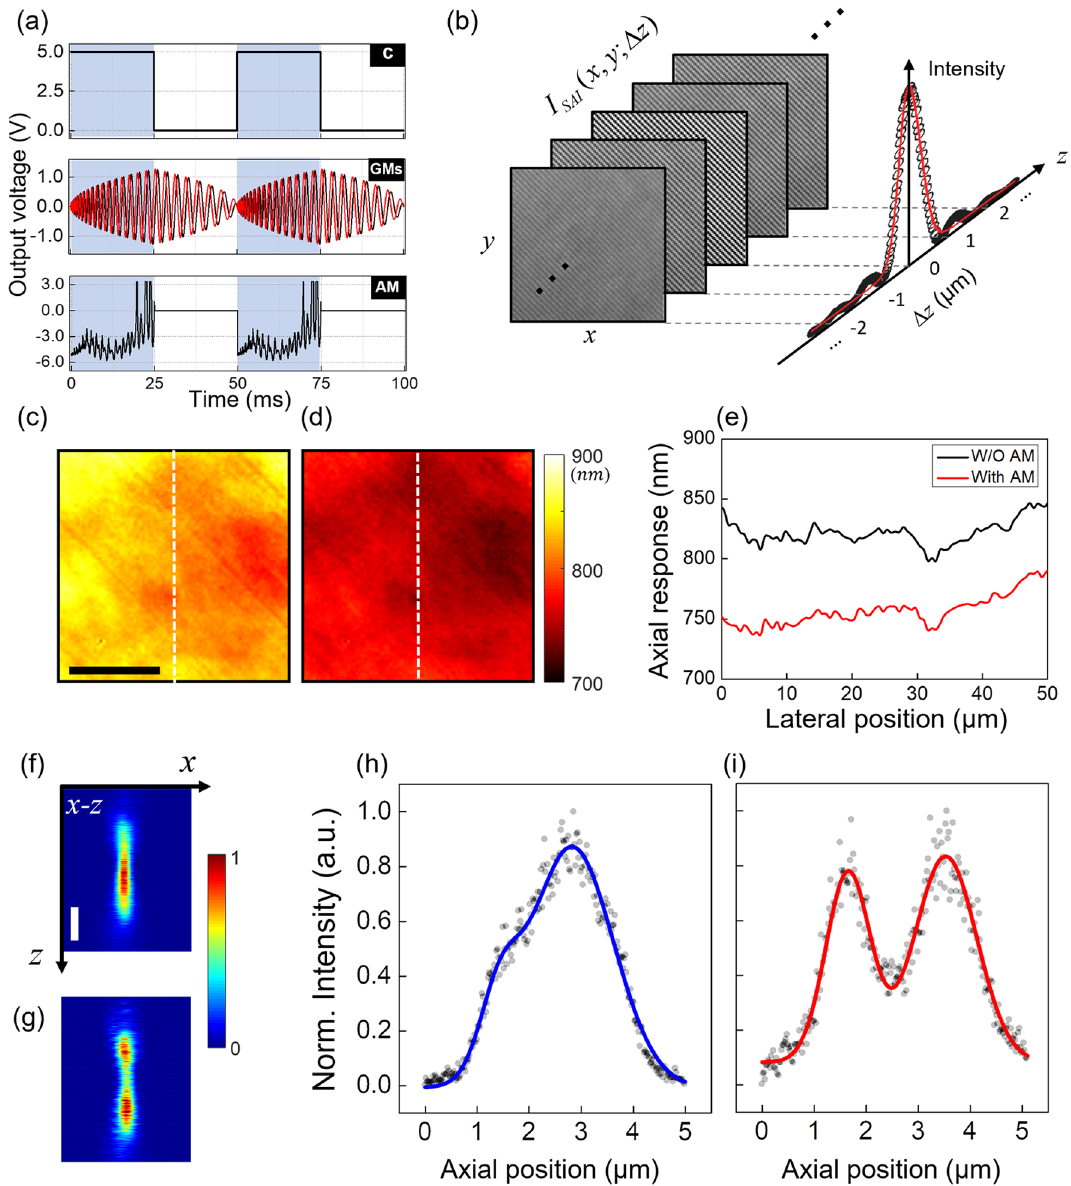
Figure 4. Enhancement of the axial resolution. ( a ) Time sequences of external triggers for the operation of devices in the setup. C: camera; GMs: Galvanometer mirrors; AM: amplitude modulator. ( b ) Measured interferograms (left) and intensity of the image (right) as a function of (cid:31) z . The red line is a Gaussian fit. ( c ) Map of the measured axial resolution over the FOV before the AM control. ( d ) The same as ( c ) after the AM control. Scale bar: 20 μm. ( e ) Section profiles along the dashed lines in ( c ) and ( d ). ( f , g ) 2-D depth ( x–z plane) images of a cluster of two magnetic beads suspended in an agarose gel without ( f ) and with ( g ) the AM control. Scale bar: 1 μm, colorbar: normalized intensity. ( h ) Projected profile of ( f ) onto the z -axis. ( i ) The same as ( h ) of ( g ). The solid lines in ( h ) and ( i ) are fitting